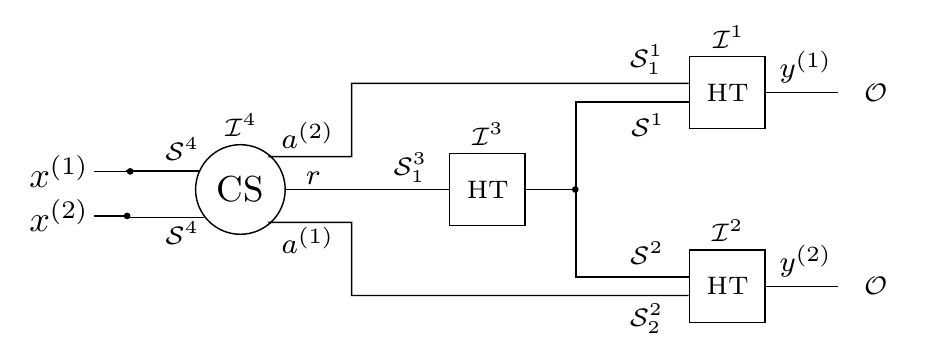
Figure 7: Illustration of common input table as composition of gadgets. Each variable x ( ‘ ) and y ( ‘ ) contains actually n shares x ( ‘ )